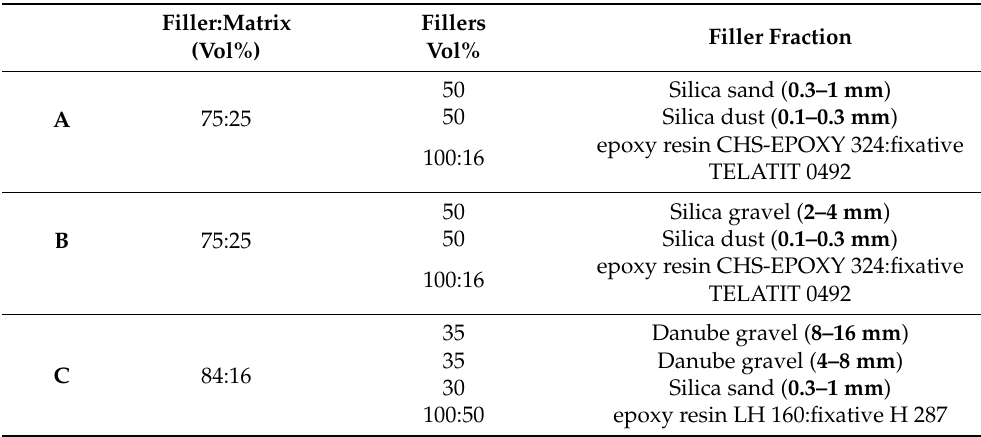
Table 1. Descriptions of Samples A–C with different filler sizes.